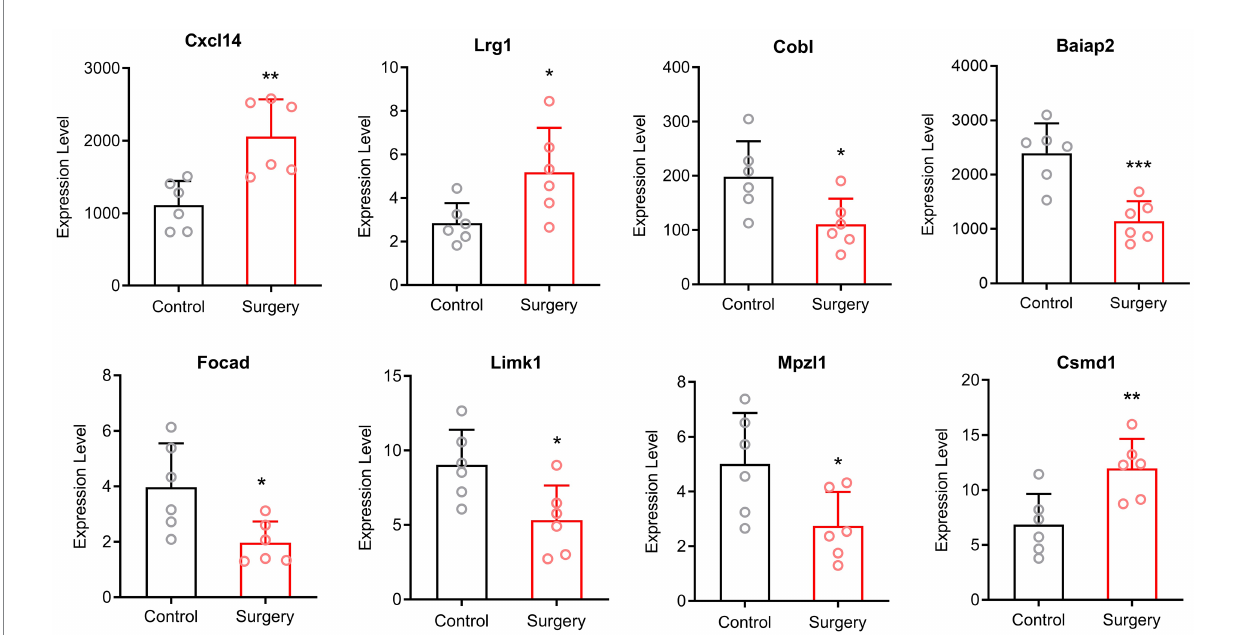
FIGURE 3 The qRT-PCR validation results. Expression of mRNAs was up-regulated in Cxcl14 and Lrg1, while down-regulated in Cobl and Baiap2 in surgery group compared with control group. Among the circRNAs, Focad, Limk1 and Mpzl1 showed down-regulation, and Csmd1 showed up-regulation in surgery group (Means ± SD, * p < 0.05, ** p < 0.01, and *** p < 0.001).